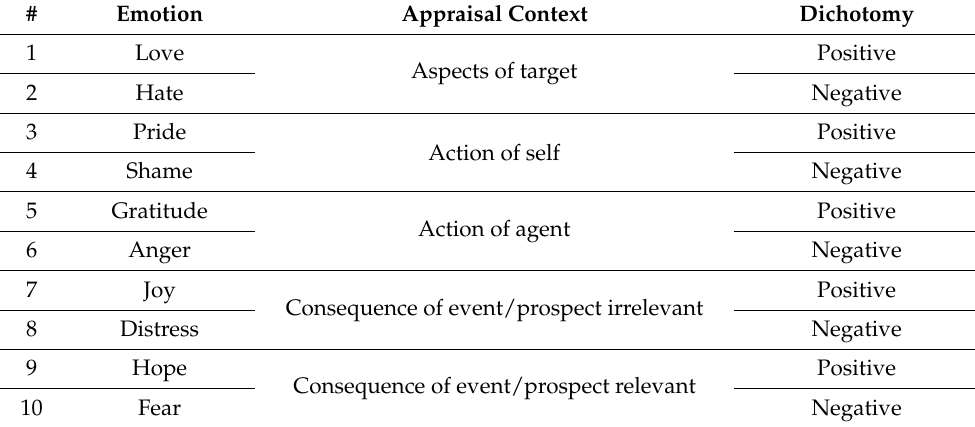
Table 1. Types and contexts of emotion.